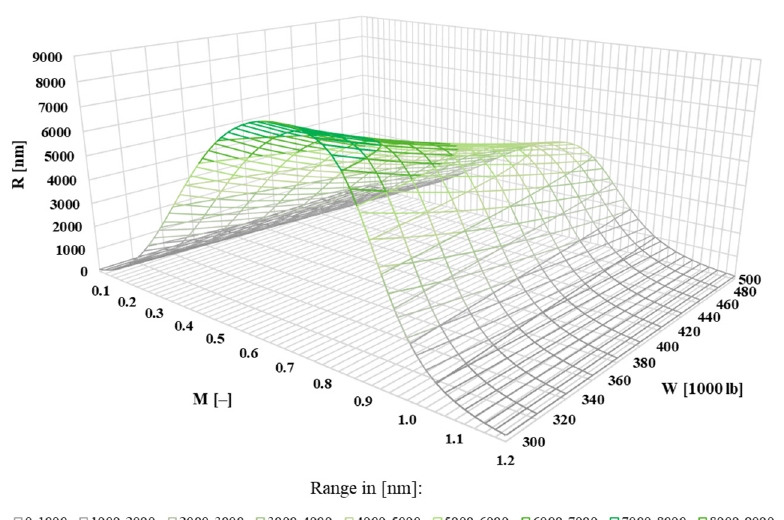
Figure 8. 3D plot visualizing influence of in-flight weight and Mach number on the range, including transonic wave drag.